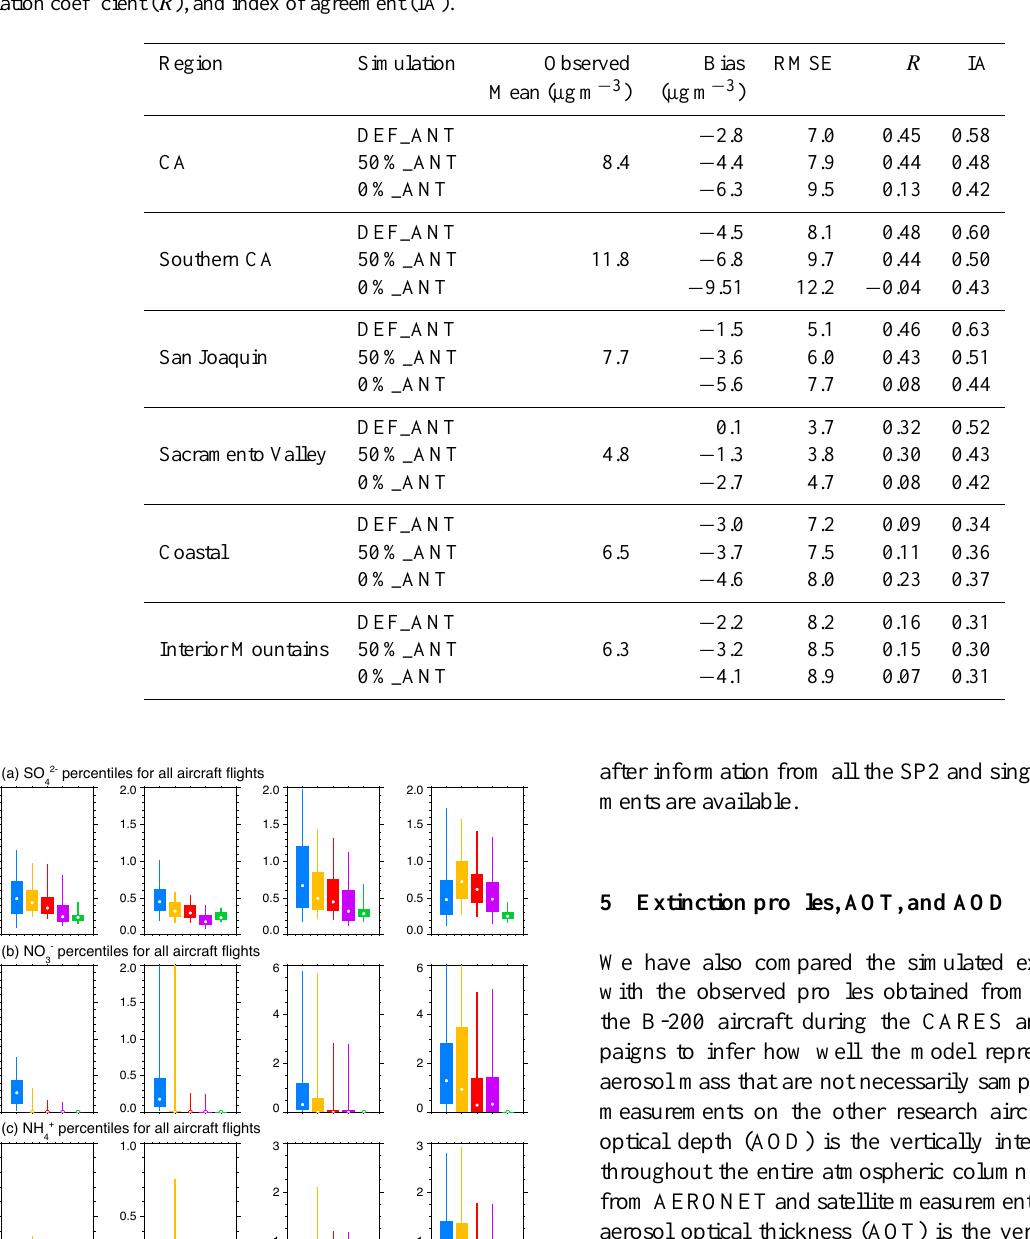
Table 14. Performance of simulated PM 2 . 5 for all the surface operational monitoring sites in terms of bias, root-mean-square error (RMSE), correlation coefficient ( R ), and index of agreement (IA).